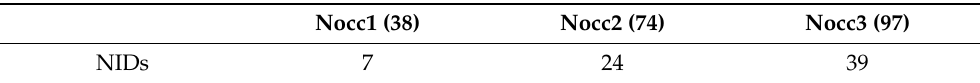
Table 2. The relationship between occlusion and IDs. Nocc1–3 represent IDs number of the three image sets, respectively.